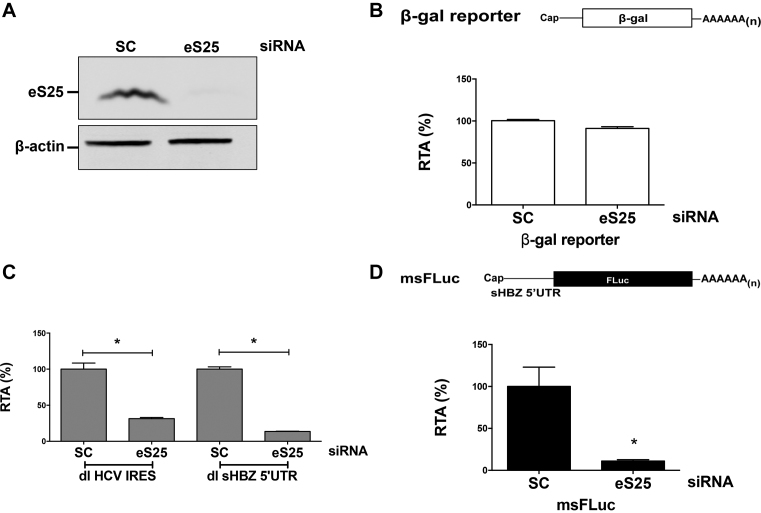
Translation mediated by the sHBZ 5′UTR requires eS25. COS-7 cells were transfected with a scrambled RNA or an siRNA that targeted eS25 mRNA together with either the msFLuc, the β- galactosidase, the dl sHBZ 5′UTR or the dl HCV IRES plasmids. Then 24 h post-transfection, protein lysates were harvested and subjected to western analysis (A), β-galactosidase assays (B) or luciferase assays (C and D) as indicated in ‘Materials and Methods’ section. (A) For western analysis, the membrane was probed with eS25 and β-actin antibodies and imaged using a LI-COR imager. (B) Effects on cap-dependent translation were measured by determining β-galactosidase activity expressed as RTA (%) relative to the scrambled control siRNA, which was set to 100%. Values are the mean (+/− SEM) for nine independent experiments, each performed in duplicate. (C) IRES activity from the dl sHBZ 5′UTR or the dl HCV IRES plasmids with or without eS25 was measured by determining the FLuc activity normalized to the transfection control β-galactosidase (FLuc/β-gal) and expressed as RTA (%) relative to the activity measured in cells transfected with the scrambled siRNA set to 100%. Values are the mean (+/− SEM) for three independent experiments, each performed in duplicate. Statistical analysis was performed by an ANOVA test followed by a Dunnett’s multiple test comparison (*P < 0.05). (D) The effect of eS25 knockdown on in vitro transcribed m7G-capped msFLuc mRNA transfected into COS-7 cells, 48 h post siRNA knockdown was determined by measuring FLuc activity 4 h post-reporter transfection and expressed as RTA (%) relative to COS-7 cells transfected with the scrambled siRNA, which was set to 100%. Values are the mean (+/− SEM) for three independent experiments, each performed in duplicate. Statistical analysis was performed by a two-tailed t-test (*P < 0.05).